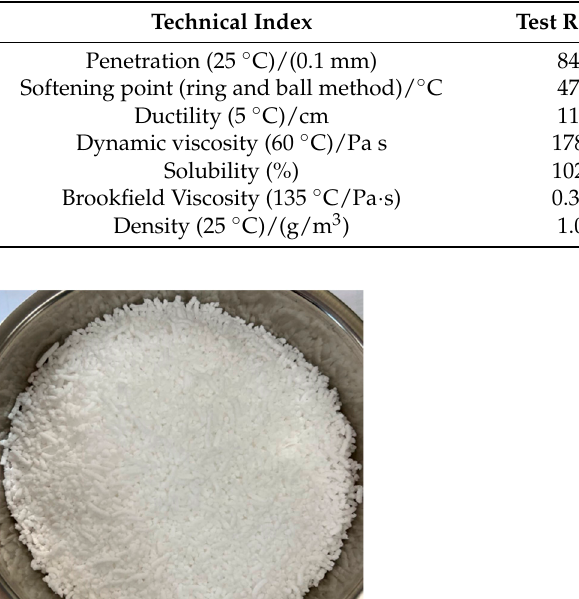
Table 1. Basic Performance Parameters of SBS.